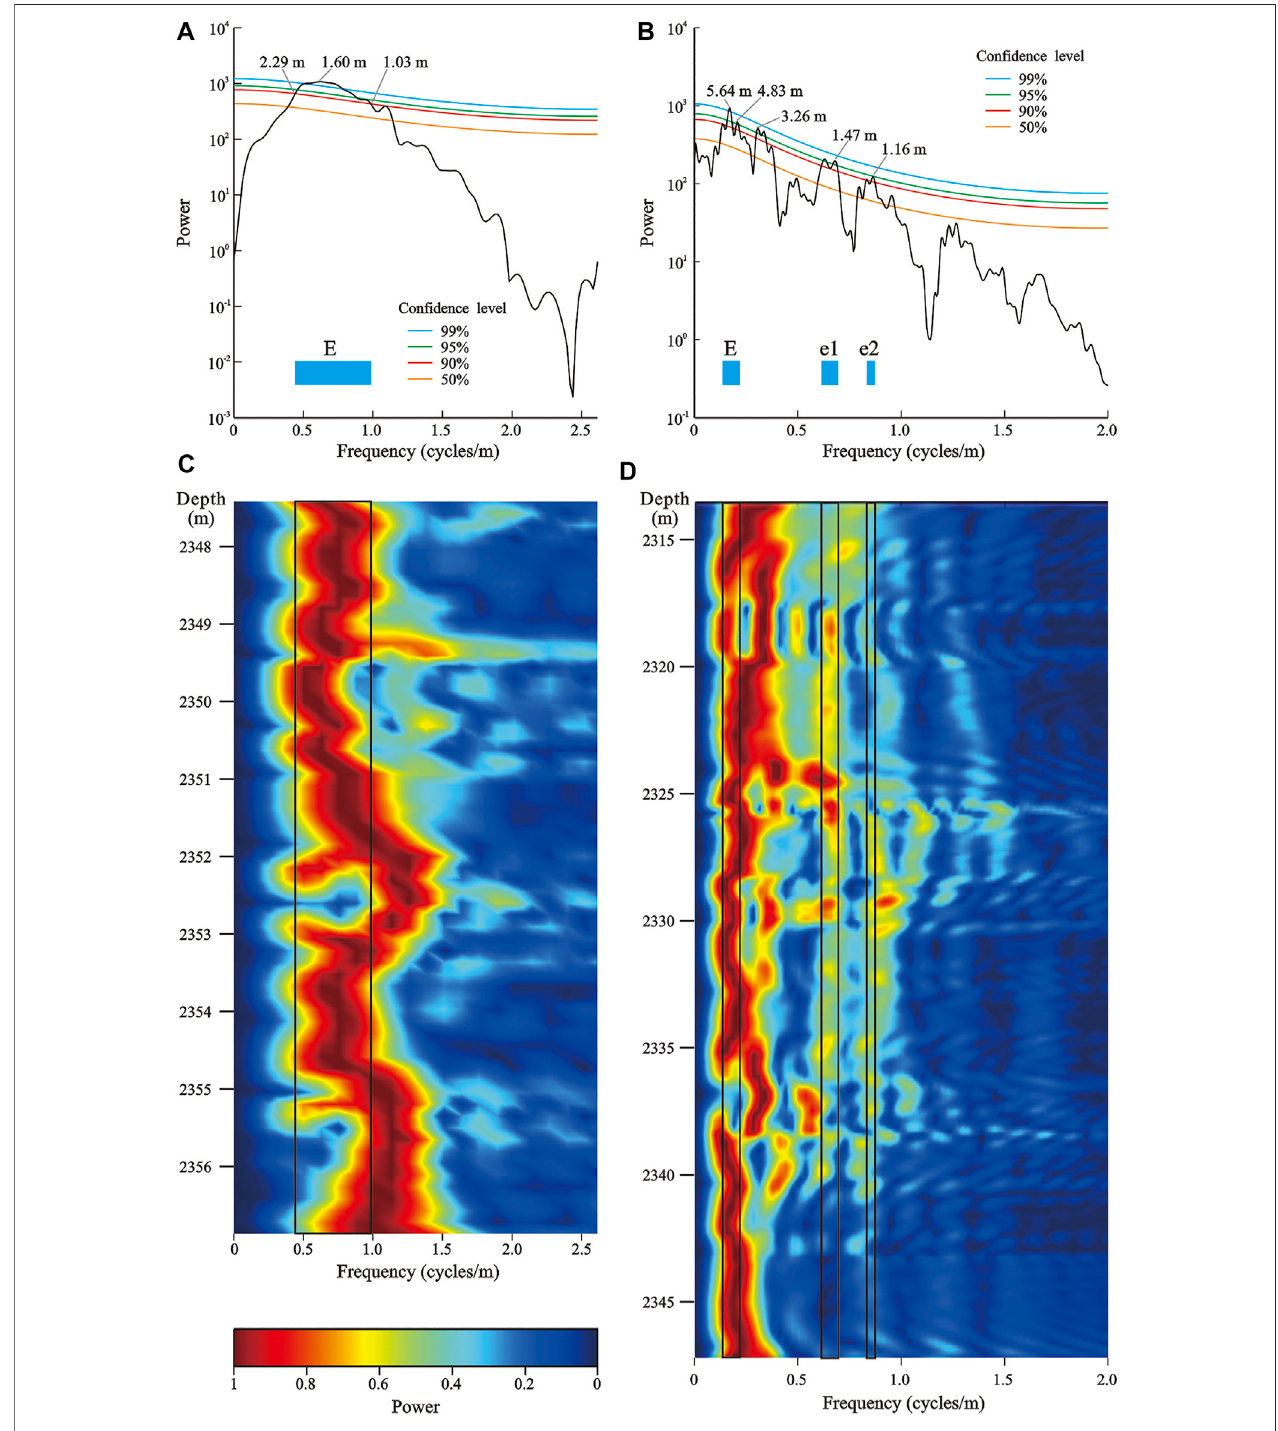
FIGURE 7 | Multitaper-method spectra and fast-Fourier transform sliding-window spectra produced from the GR data series for the Wufeng Formation ( A and C , respectively) and the lower Longmaxi Formation ( B and D , respectively) in well N211 of the Upper Yangtze Region.